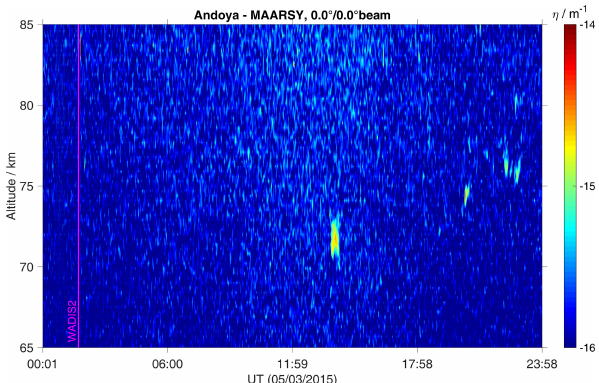
Figure 2. Volume reflectivity measured by MAARSY on 5 March. Some short-living echoes were observed around noon and in the late evening but not around the WADIS-2 rocket